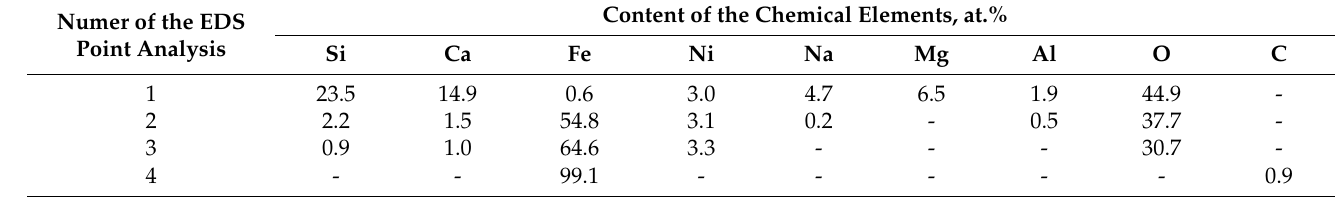
Figure 4. SEM images of the coating-steel interface formed at 820 °C ( a ) and the trace from a ball impact (6 J) on the surface of the coating obtained at 850 °C ( b ), the elemental composition corresponding to points 1-4 is shown in Table 4. Table 4. Chemical composition of the metal substrate, different zones of the interface and coating (marked in Figure 4). Data of the EDS point